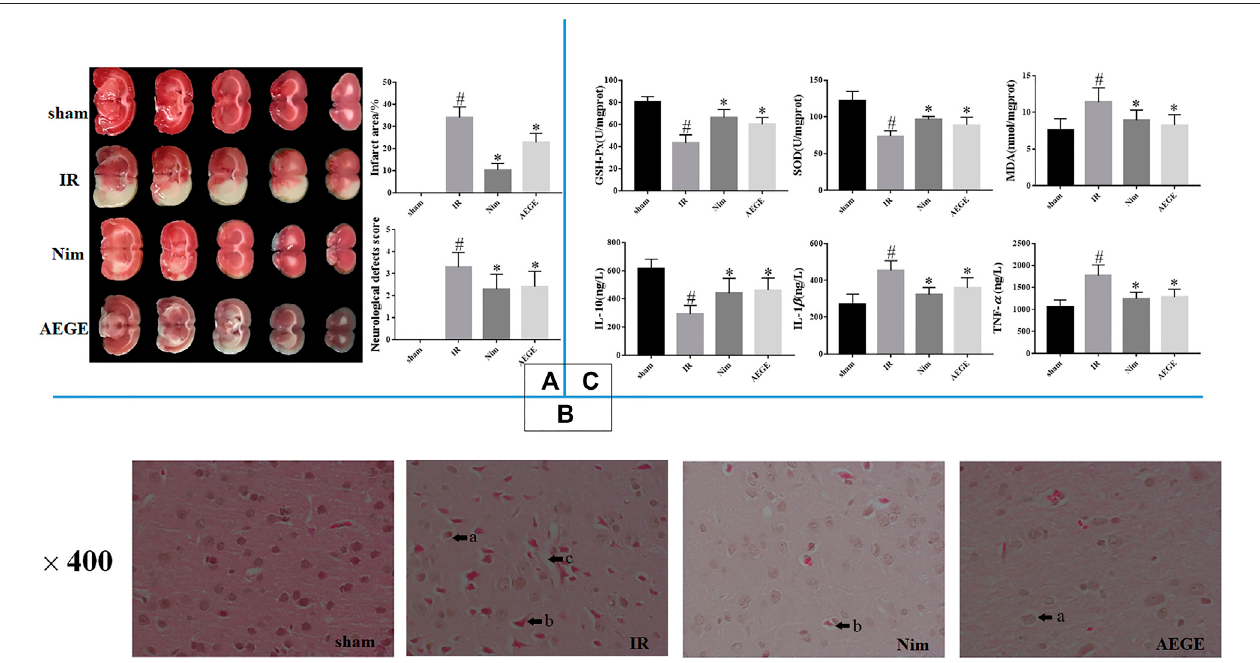
FIGURE 1 | Changes in brain histopathology and biochemical indices in rats with cerebral ischemia-reperfusion injury. (A) TTC staining, neurological defects, and infarct area. (B) H&E staining. The area marked with an “ a ” indicates peripheral demyelination; “ b ” indicates nuclear pyknosis, nerve cell atrophy, and neuronal degeneration; and “ c ” indicates cytoclasis of the brains in MCAO/R rats. (C) Changes in SOD, GSH-Px, MDA, IL-10, IL-1 β , and TNF- α levels in rat brains. Data are expressed as mean ± SD. “ # ” represents sham group vs . the IR group (# p < 0.05); “ * ” represents IR group vs . the AEGE group (* p < 0.05).